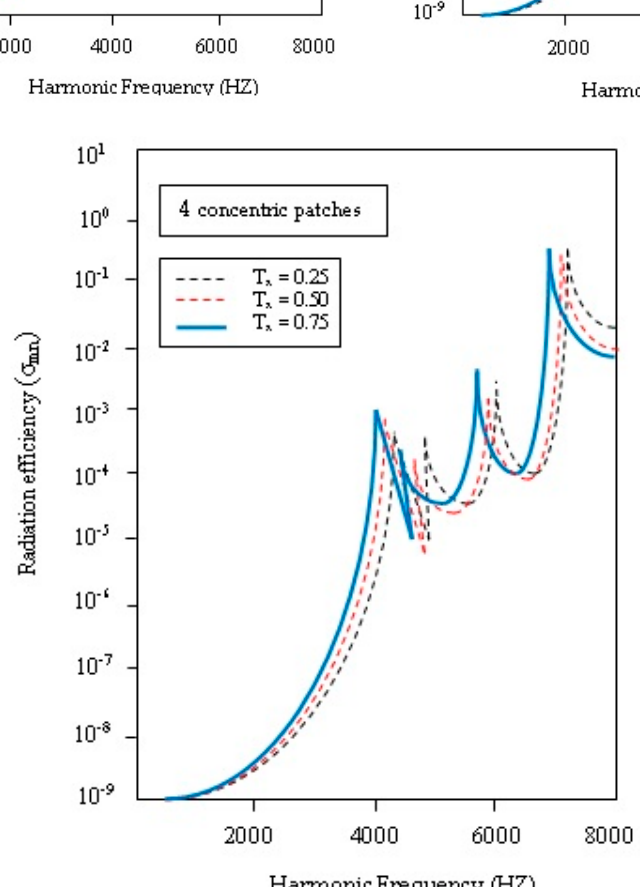
Figure 25. Numerical comparison of radiation efficiency ( σ mn ) for annular plate having parabolically decreasing thickness variations (Case I) with different attachment of (a) 1 concentric patch (b) 2 concentric patches and (c) 4 concentric patches for taper ratio T x = 0.75.